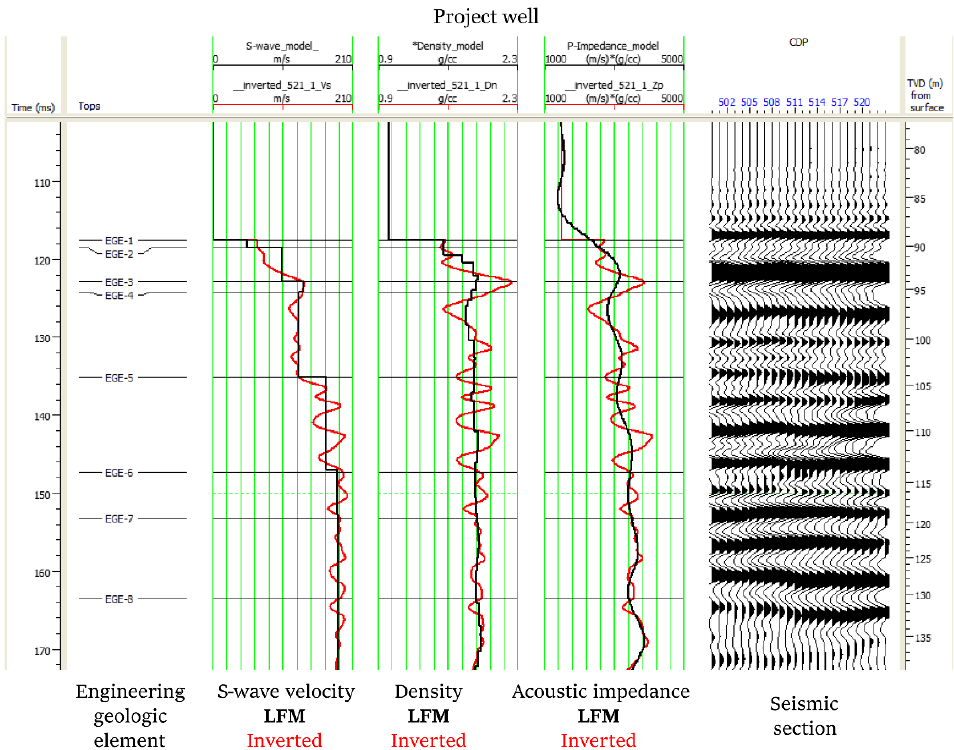
Figure 2. The low-frequency and the inverted models of S-wave velocity, density, and acoustic im- pedance along the project well. The seismic section in the vicinity of the well is shown on the